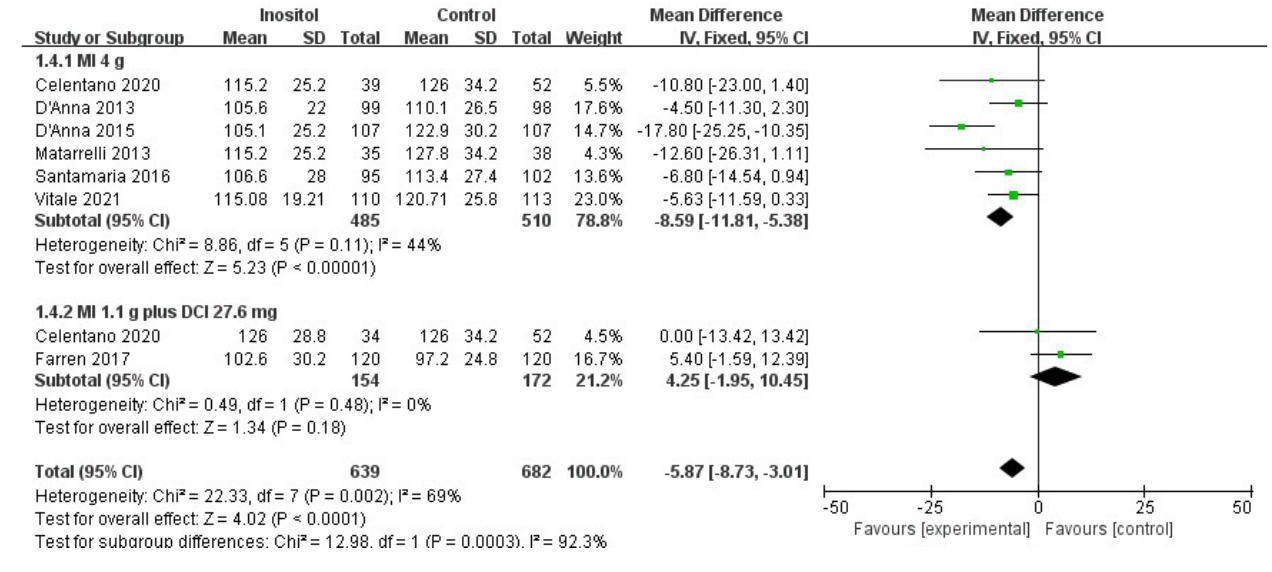
Figure 7. Inositol vs. control: 2-h OGTT [14–20].